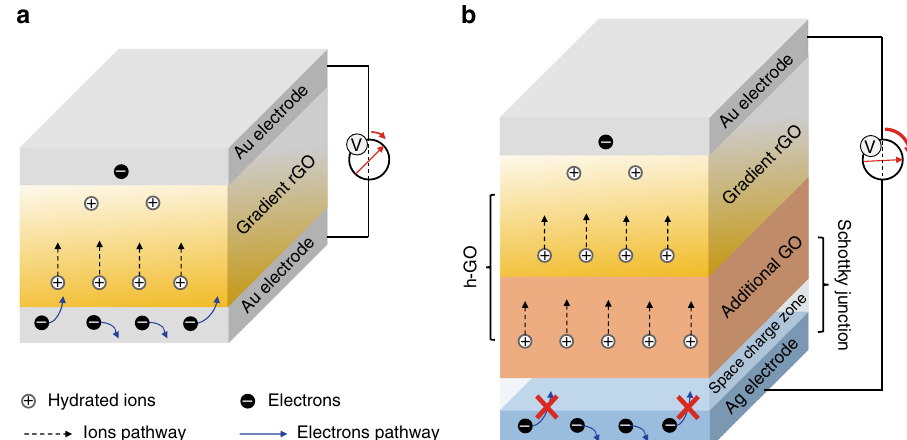
Fig. 1 Additional feed-layer enhanced hygroelectric generator. Schematic of previous hygroelectric generator (HEG) composed of single gradient reduced graphene oxide (rGO) ( a ) and well-designed HEG ( b ) developed with heterogeneous graphene oxide (h-GO) and well-matched electrodes. a Movable hydrated ions dissociate in gradient rGO with concentration difference and diffuse from high-concentration side to low-concentration side. Induced free electrons in electrodes fl ow through both the external circuit and inner gradient rGO layer to balance the built-in electric potential. b Feed-layer with additional graphene oxide (GO) supplies the depletion of ions in gradient rGO, and special electrode/h-GO interface can form a well-matched space charge zone, which acts as a “ gate ” to block free electrons through h-GO and regulates its fl ow direction, largely promoting the electric